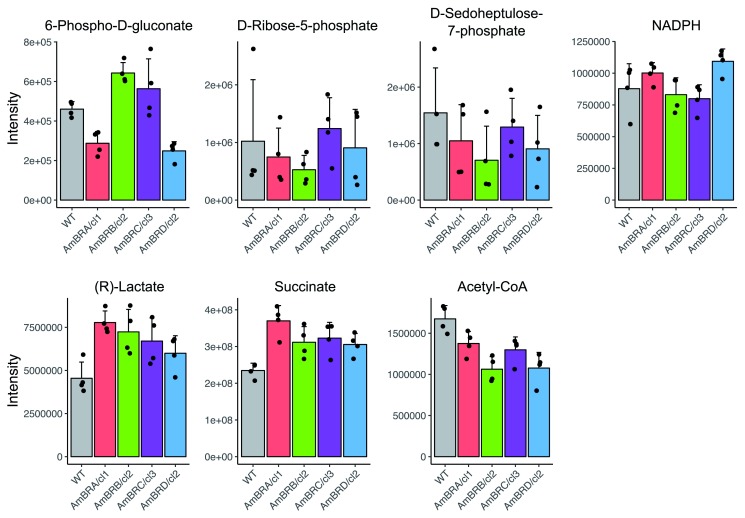
Metabolite intensity plots for metabolites involved in carbohydrate and energy metabolism.Mean intensities across four biological replicates are shown, with error bars representing standard deviation. Black points represent intensities of individual replicates.